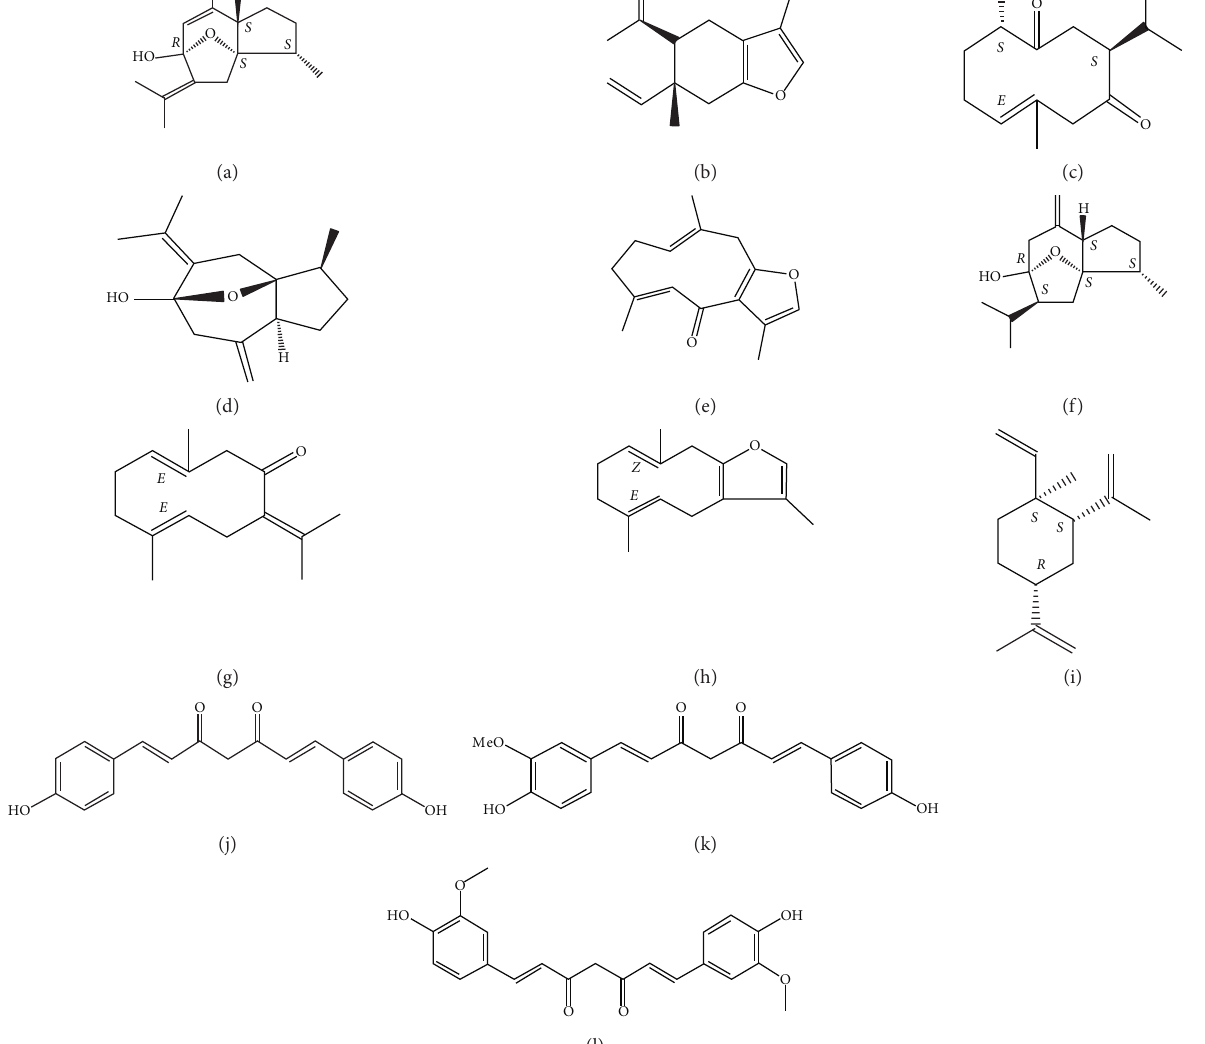
Figure 1: The structure of the standard substances. (a) Curcumenol. (b) Curzerene. (c) Curdione. (d) Isourecumenol. (e) Furanodienon. (f) Curcumol. (g) Germacrone. (h) Furanodiene. (i) β -elemene. (j) Bisdemethoxycurcumin. (k) Demethoxycurcumin. (l)